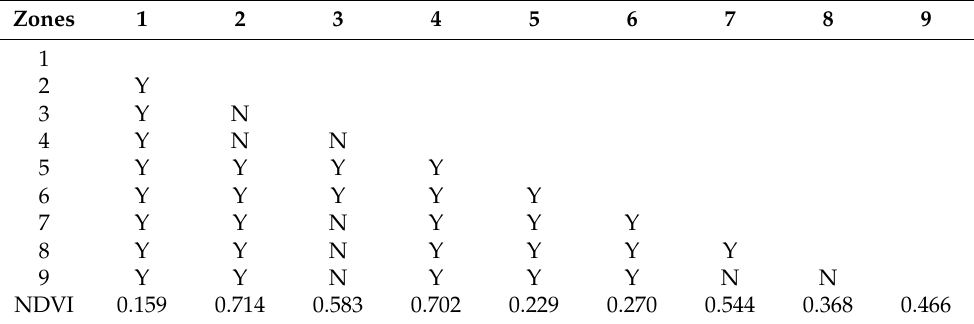
Table 11. Mean NDVI value and significant differences in terms of vegetation types between two regions. Zones